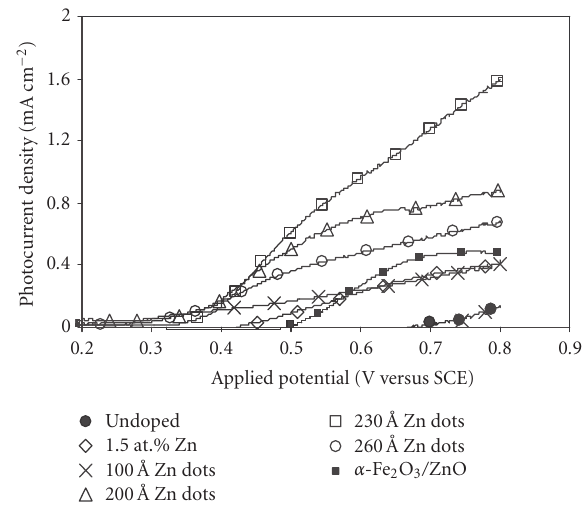
Figure 6: Photocurrent density versus applied potential curve for α -Fe 2 O 3 (all samples) in 13 pH NaOH electrolyte